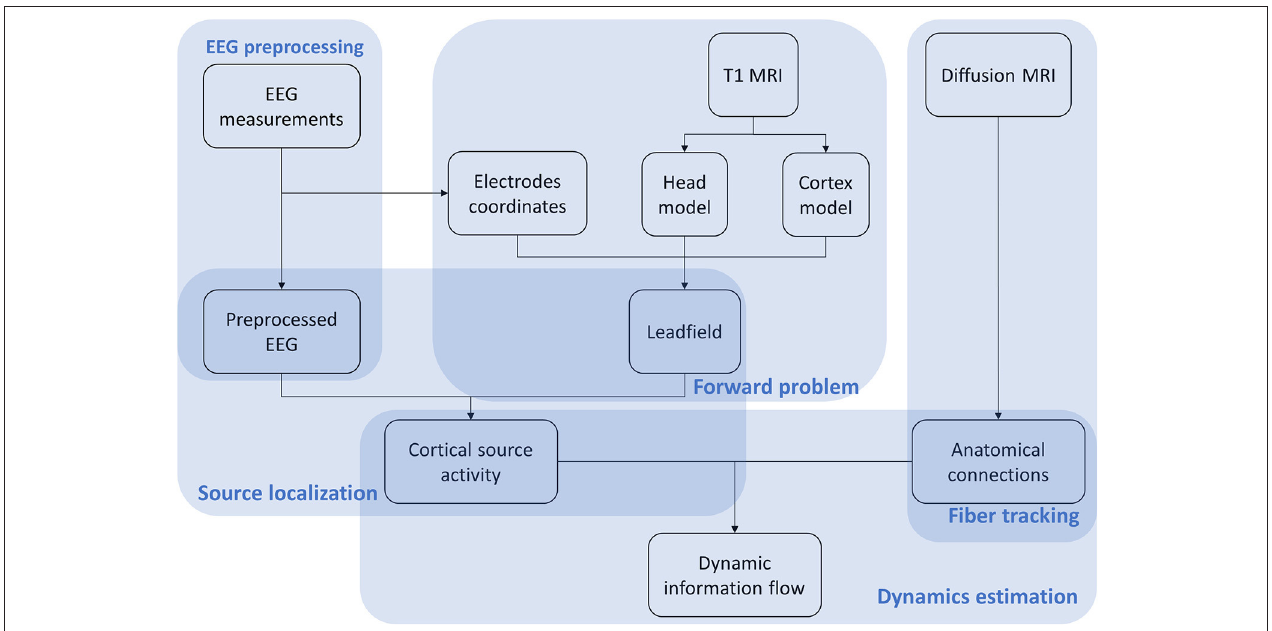
FIGURE 2 | Workflow of the VBMEG method. EEG, anatomic and diffusion weighted MRIs are first preprocessed. Then EEG sources are estimated using hVB approach. By combining sources and anatomical connections extracted from diffusion MRI, the linear connectome dynamics model is built leading to the estimation of dynamic information flow traveling between sources. The results are visualized individually for each subject